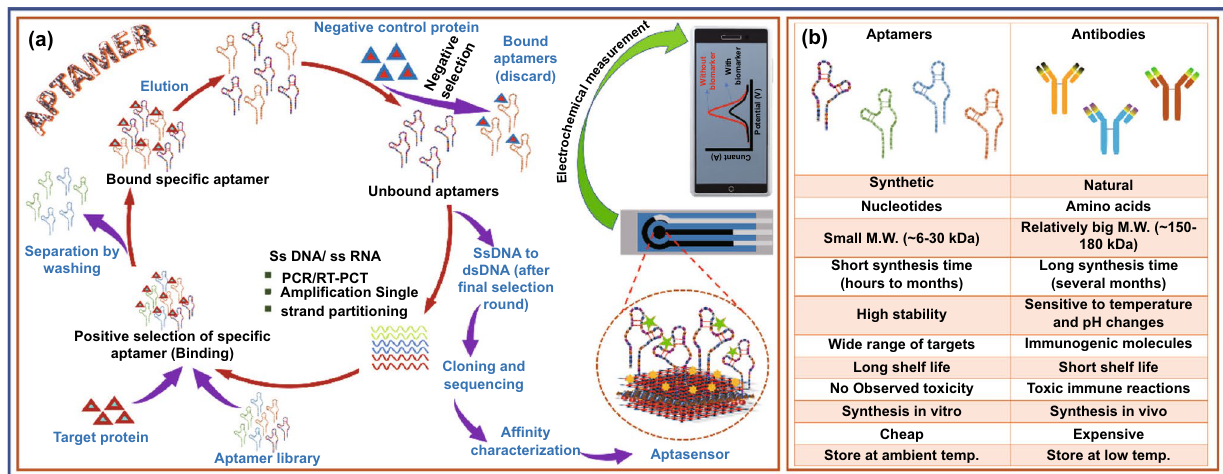
Fig. 3 a Synthesis method for aptamer and detection through electrochemical method, b comparison of aptamers and antibodies as biorecogni- tion element